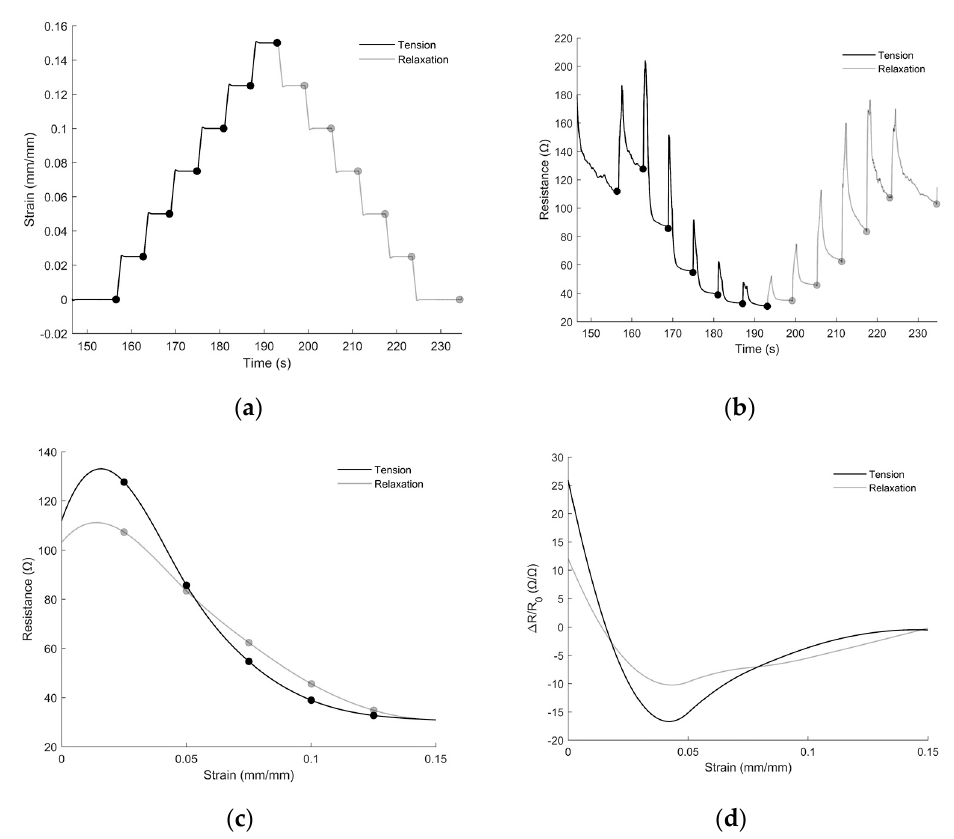
Figure 4. ( a ) The strain profile of an incremental strain test (black line indicates a sensor’s perfor- mances as it is pulled in tension, and the gray line indicates the sensor’s performance as it is relaxed; dots represent the points at which empirical data were collected from the resistance test after the transient spike had dissipated for all sub-figures). ( b ) The electrical response from the sensors over time as the strain gauges were pulled to different incremental strains. ( c ) The strain–resistance rela- tionship interpolated from the tensile tests. ( d ) The gauge factor (relative change in resistance with respect to strain). Spline—fit curves were used to interpolate the resistance of the sensor under static conditions between the empirical points. The derivative of the spline-fit curves over the spline fits depicts the relative sensitivity of the sensor at different strains.